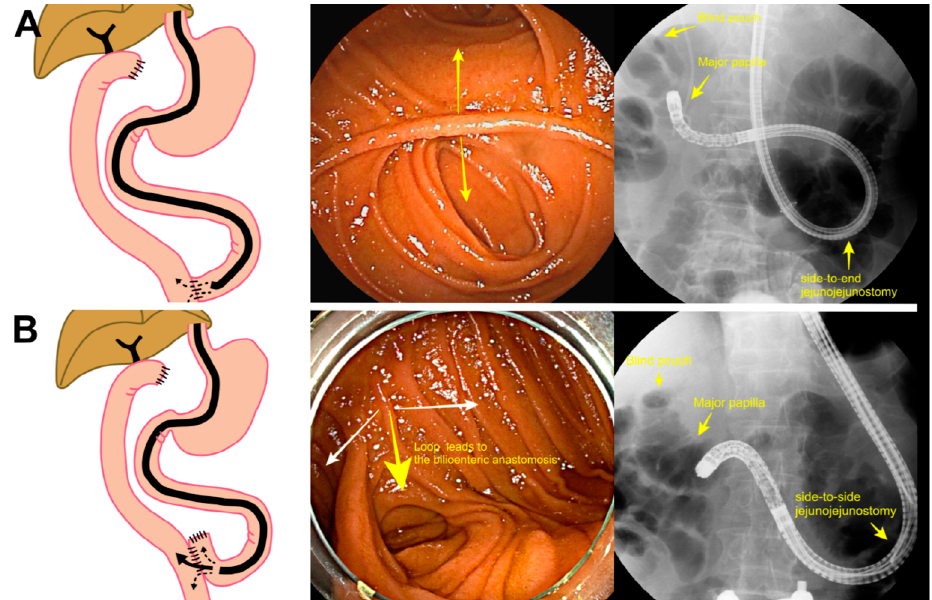
Figure 1. Type of jejunojejunostomy in Roux-en-Y reconstruction. ( A ) Schema of the operation procedure of side-to-end jejunojejunostomy; endoscopic view encountering two-pronged lumens at the jejunojejunostomy; fluoroscopic image showing the short-type double-balloon enteroscope in the afferent loop. ( B ) Schema of the operation procedure of side-to-side jejunojejunostomy; endoscopic view encountering three-pronged lumens at the jejunojejunostomy; fluoroscopic image showing the cap-assisted colonoscope in the afferent loop.